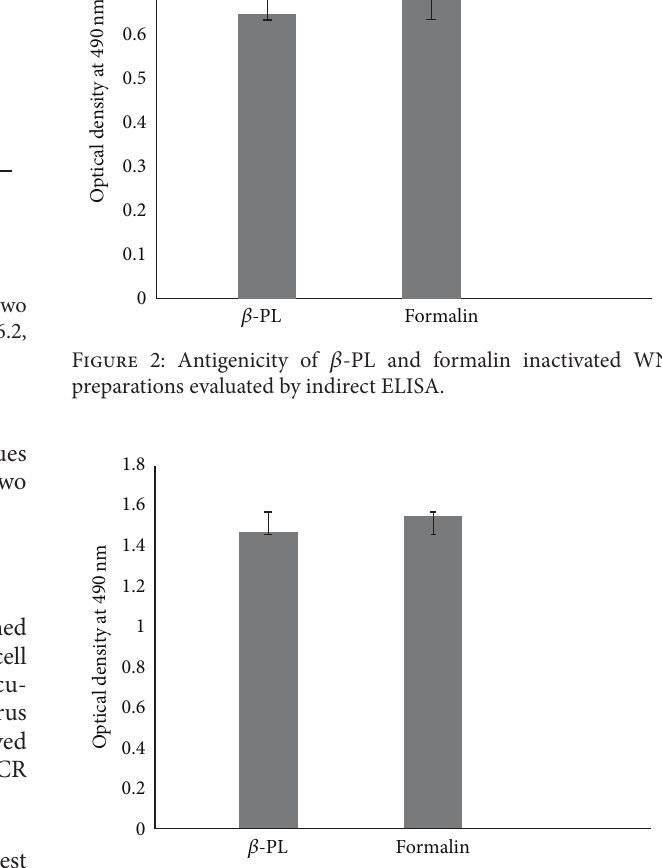
Figure 3: Humoral immune response induced in mice model by 𝛽 - PL and formalin inactivated WN preparations evaluated by indirect